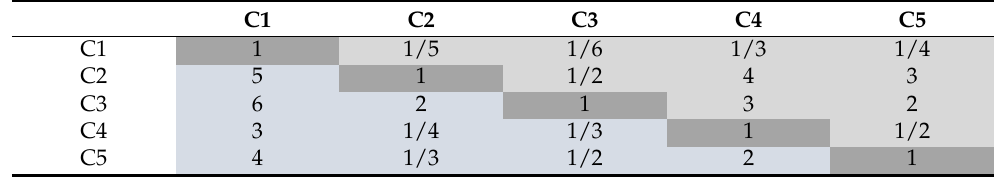
Table 3. Pairwise comparison